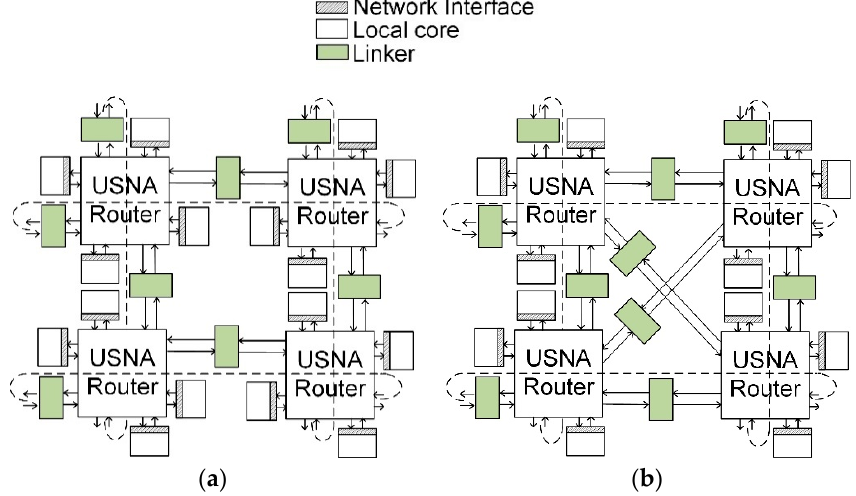
Figure 2. Examples of 2 × 2 torus USNA configurations ( a ) with 16 local cores and ( b ) with 12 local cores.